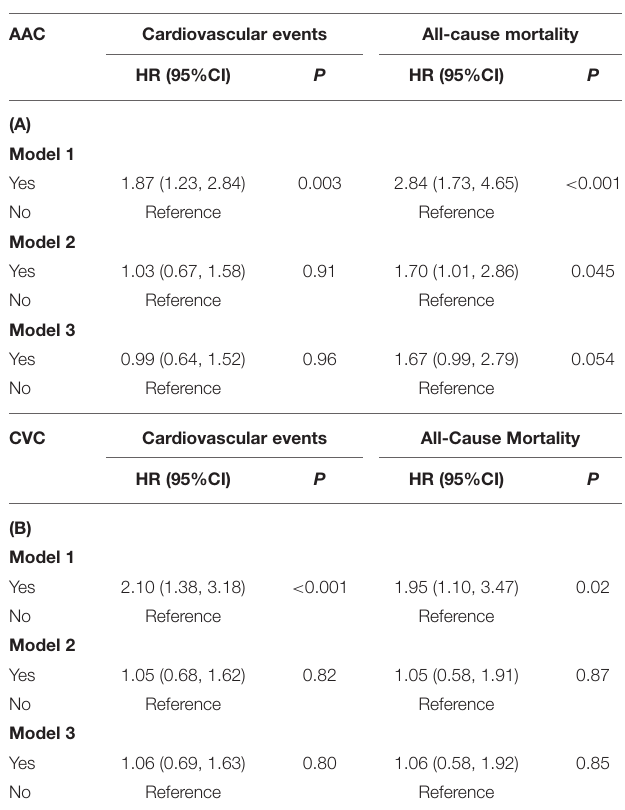
TABLE 4 | (A) Cox proportional hazards regression model for all-cause mortality and cardiovascular events with AAC as the exposure factor. (B) Cox proportional hazard regression model for all-cause mortality and cardiovascular events with CVC as the exposure factor.